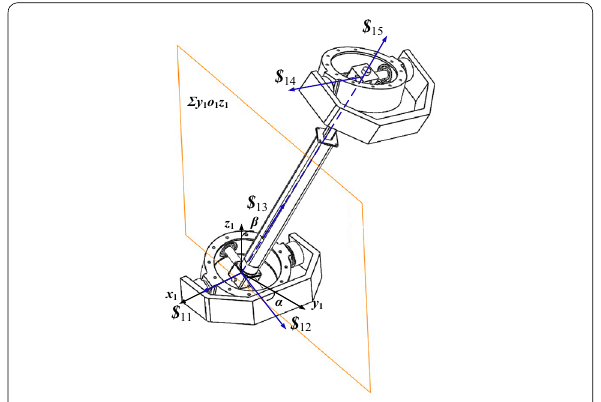
Figure 6. (rA-4)P(rA-3)